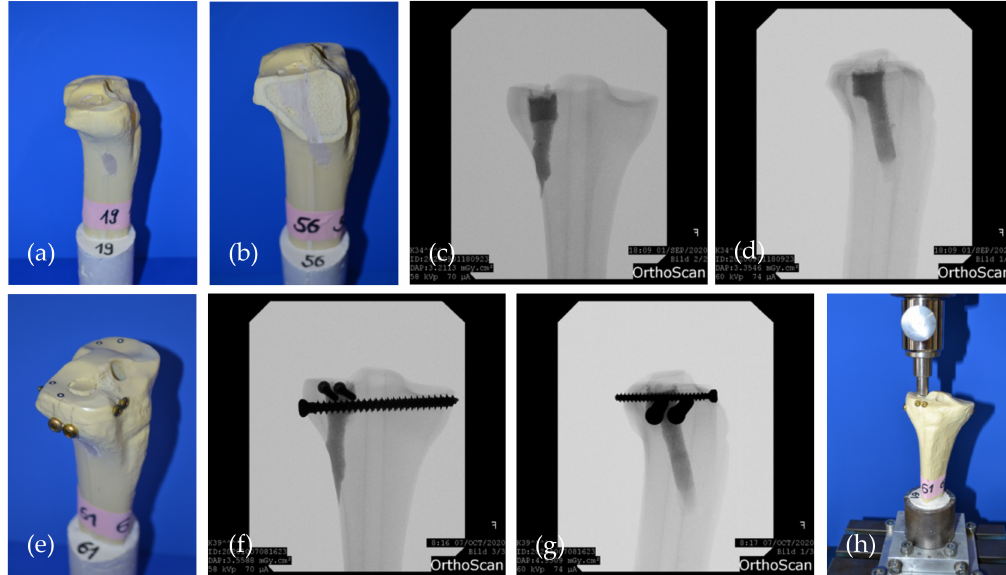
Figure 4. The two groups evaluated in the fracture model are shown: ( a ) Specimen where the drill channel was filled with bone cement MPC_25 and no additional screws were added; ( b ) Sagittally cut through the drill channel filled with bone cement; ( c ) Corresponding a.p. and ( d ) lateral x-rays of a specimen of the bone cement only group; ( e ) Specimen where four screws in the jail technique were drilled through the cement body after pre-setting of 15 min; ( f ) Corresponding a.p.; and ( g ) lateral x-rays of a specimen of the jail group. The screws support the reduced fracture like a grid; ( h ) Biomechanical test set-up where the load on the reduced fracture fragment is applied by the 12 mm indenter previously used for fracture